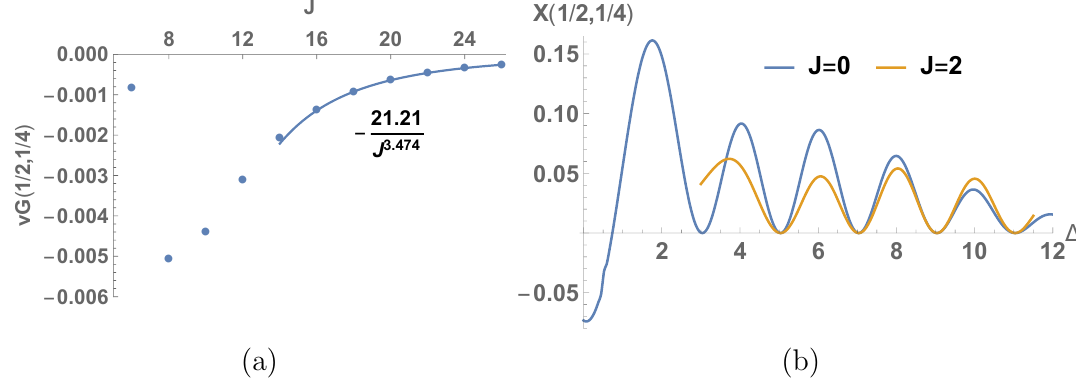
Figure 7 . (a) High-spin tail of the contribution of the lowest-twist family [ (cid:27)(cid:27) ] 0 ;J to the correlator in eq. (5.12). Operators of spin 28 and higher were resummed using the power-law (cid:12)t. (b) \Bootstrap functional" obtained by evaluating the contribution of spin-0 and spin-2 exchanged operators of dimension (cid:1) to the dispersion integral X ( 1 ; 1 ) in eq. (5.14), with external dimensions (cid:12)xed to 2 4 (cid:1) (cid:27) . A rescaling envelope was applied. Note that the curves have double zeros at non-leading double-twist